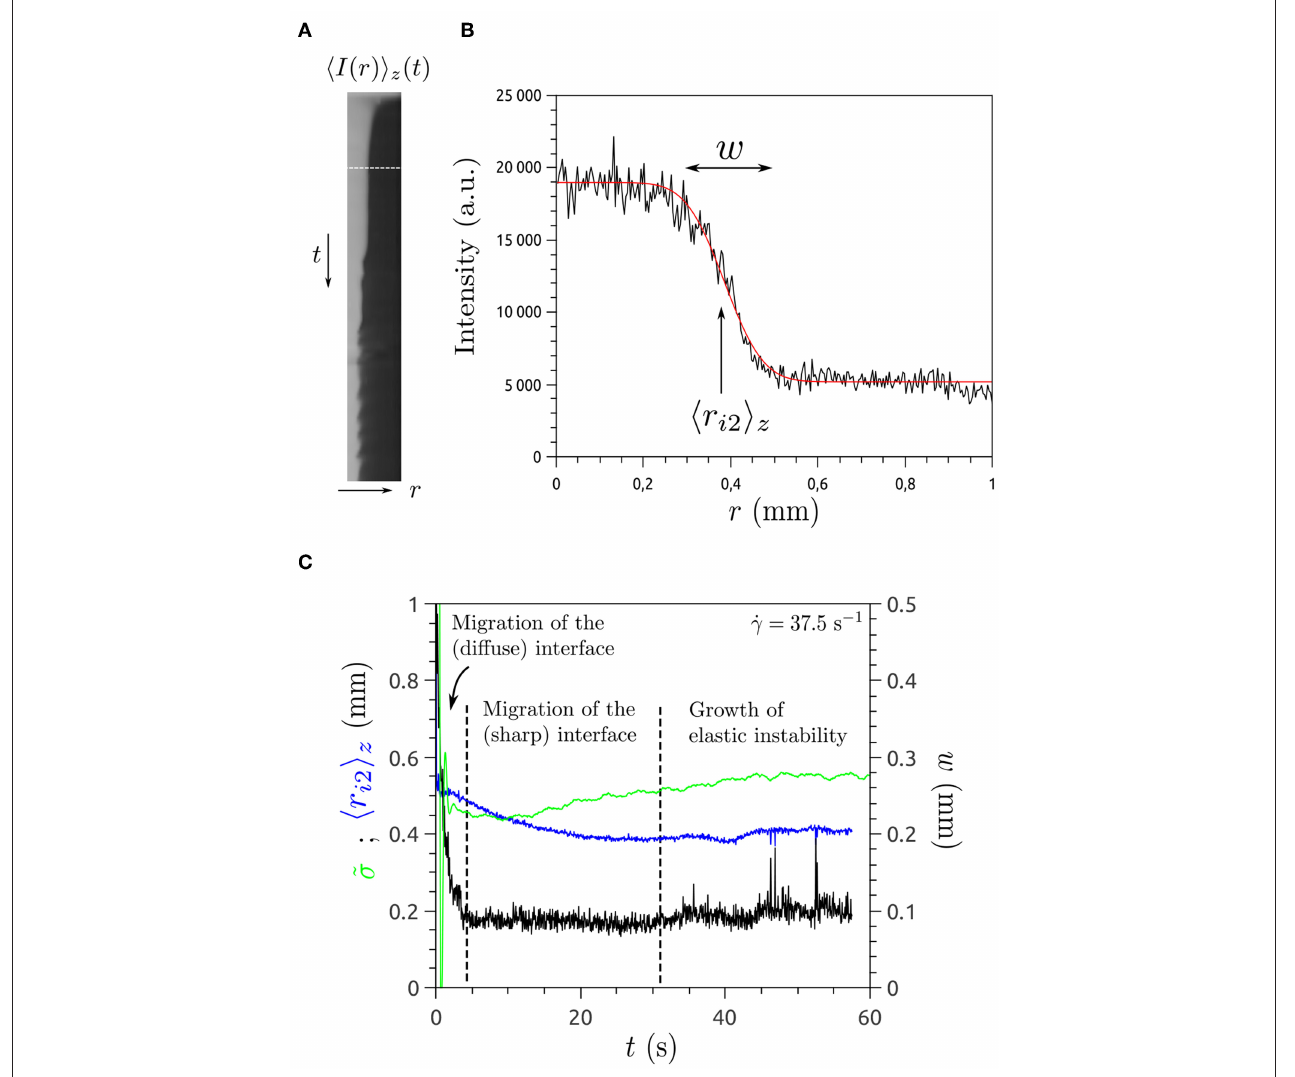
FIGURE 2 | Sketch of measurement of interface properties during stress relaxation after strain rate step from a sample initially at rest. (A) Space-time plot showing shear band migration after a step, where the white band signifies turbidity in light transmission. (B) Spatial profile across shear band along the white line in (A) showing a well-formed interface. (C) Stress relaxation showing the region where a well-formed band migrates, from which the diffusion constant was inferred by fitting the r i 2 relaxation to the predictions of the d-JS model. Here is the position of the interface between band, w is its apparent width, and h i z stress. Adapted with permissions from Fardin et al. [21], copyright by American Institute of